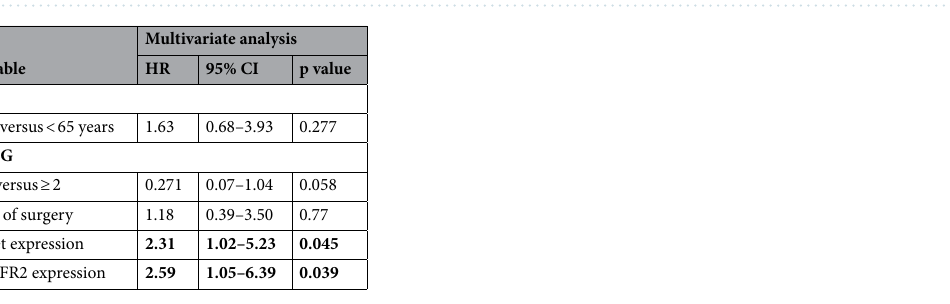
Table 2. Analysis of independent predictors of time to progression of GBM patients while on bevacizumab (TTP-2) based-therapy. HR hazard ratio. Results indicated in bold are significant